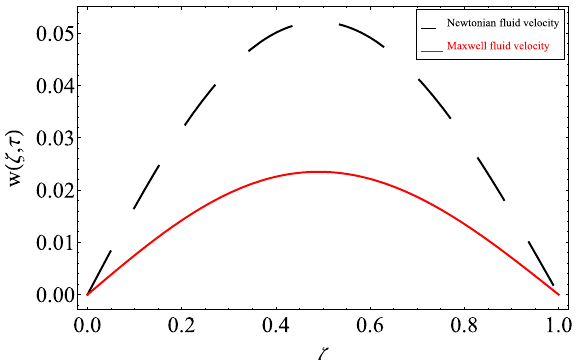
Figure 13. Comparison of the present results with the published results of Khalid et al. 53 .